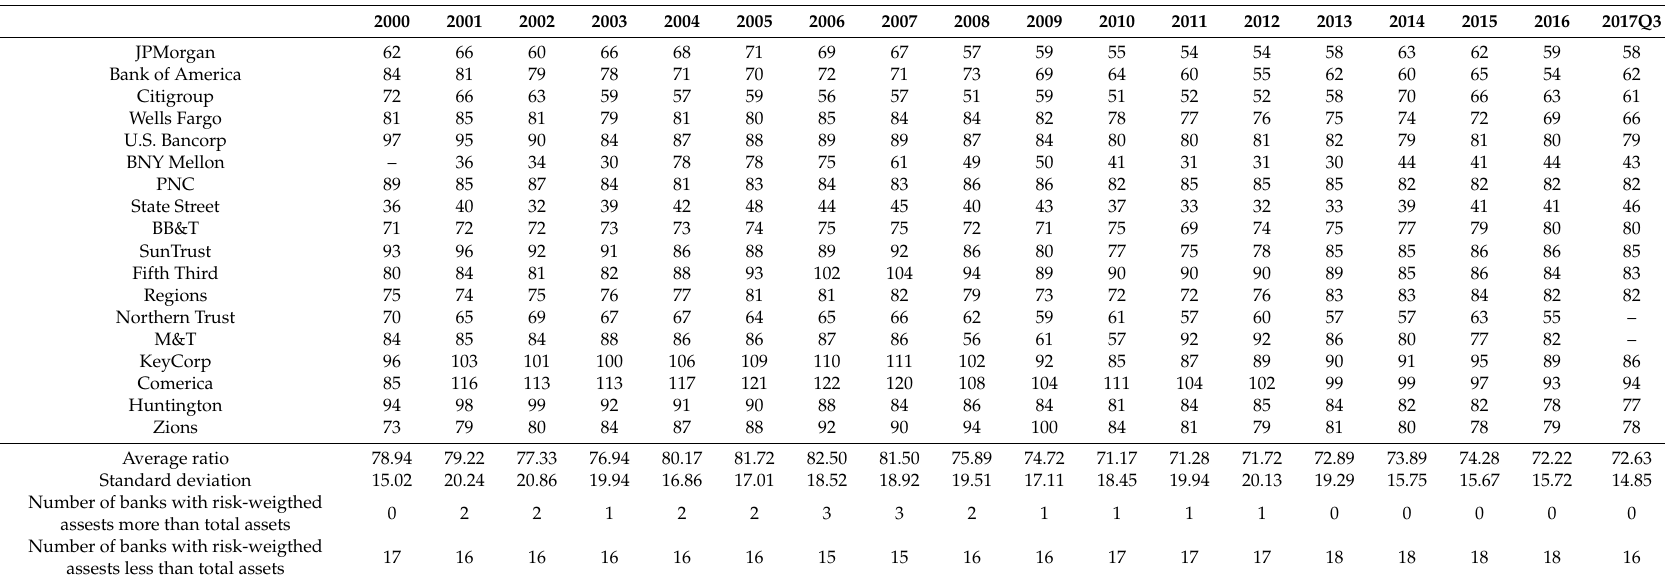
Table A3. Risk-Weighted Assets as a Percentage of Total